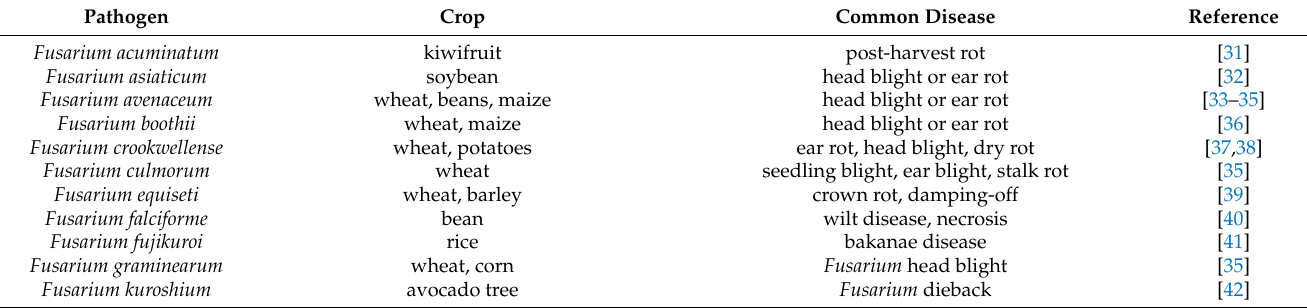
Table 1. The most common Fusarium species known to infect cereal crops, fruits and vegetables.